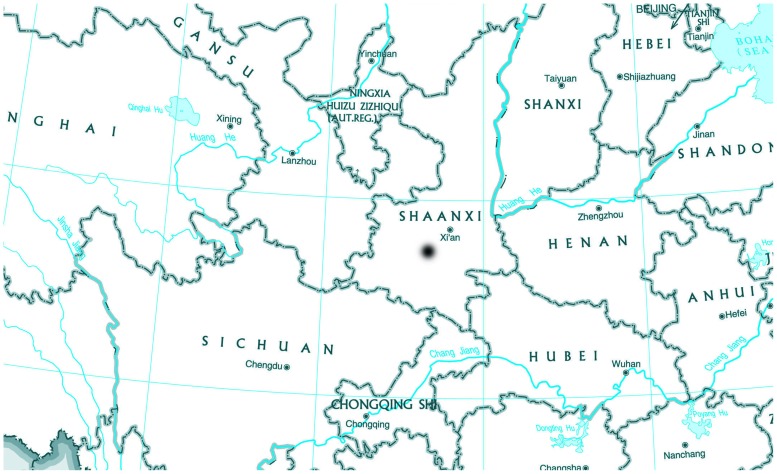
Study site location.